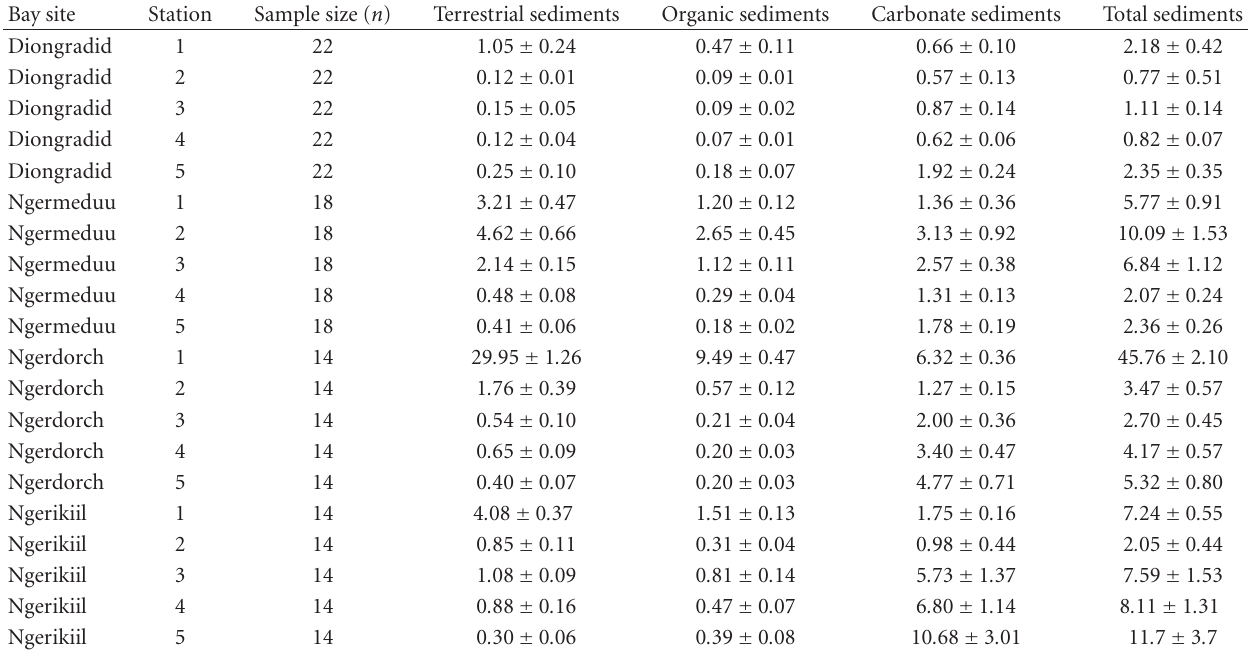
Table 2: Terrestrial, organic, and carbonate sediments recorded in sediment traps at the di ff erent stations at the four reef sites. Numbers shown are mean sedimentation rates in mg cm − 2 d − 1 ±